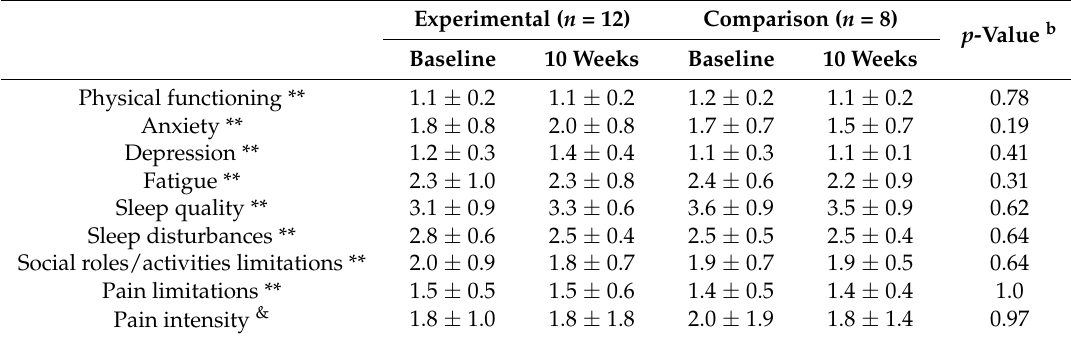
Table 5. Descriptive statistics for quality of life outcomes by group at baseline and 10 weeks * ,a